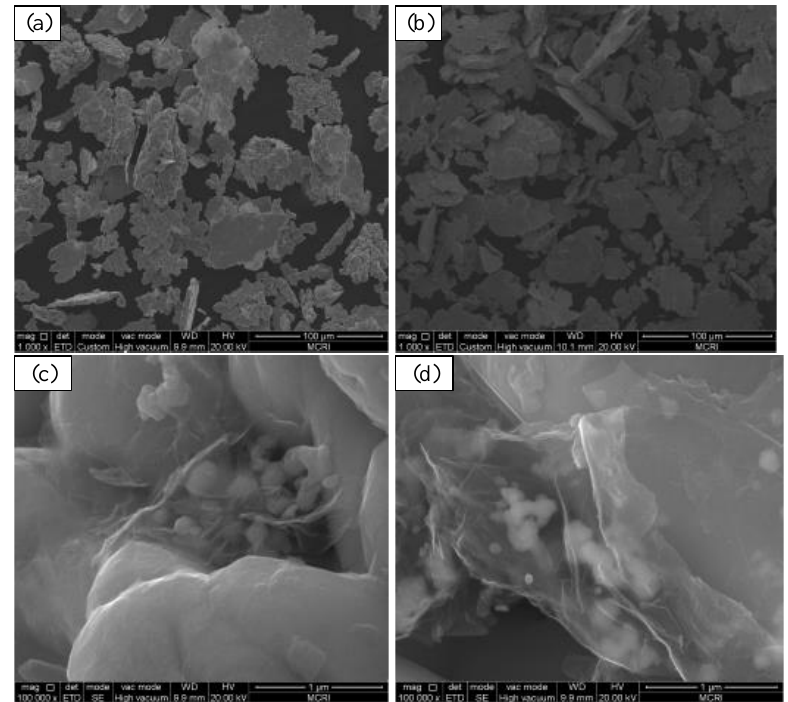
Figure 2. SEM images of biochar and biochar-graphene (BG) composites at 300 °C and 600 °C. ( a ) B 300 ; ( b ) B 600 ; ( c ) BG 300 ; ( d ) BG 600 .